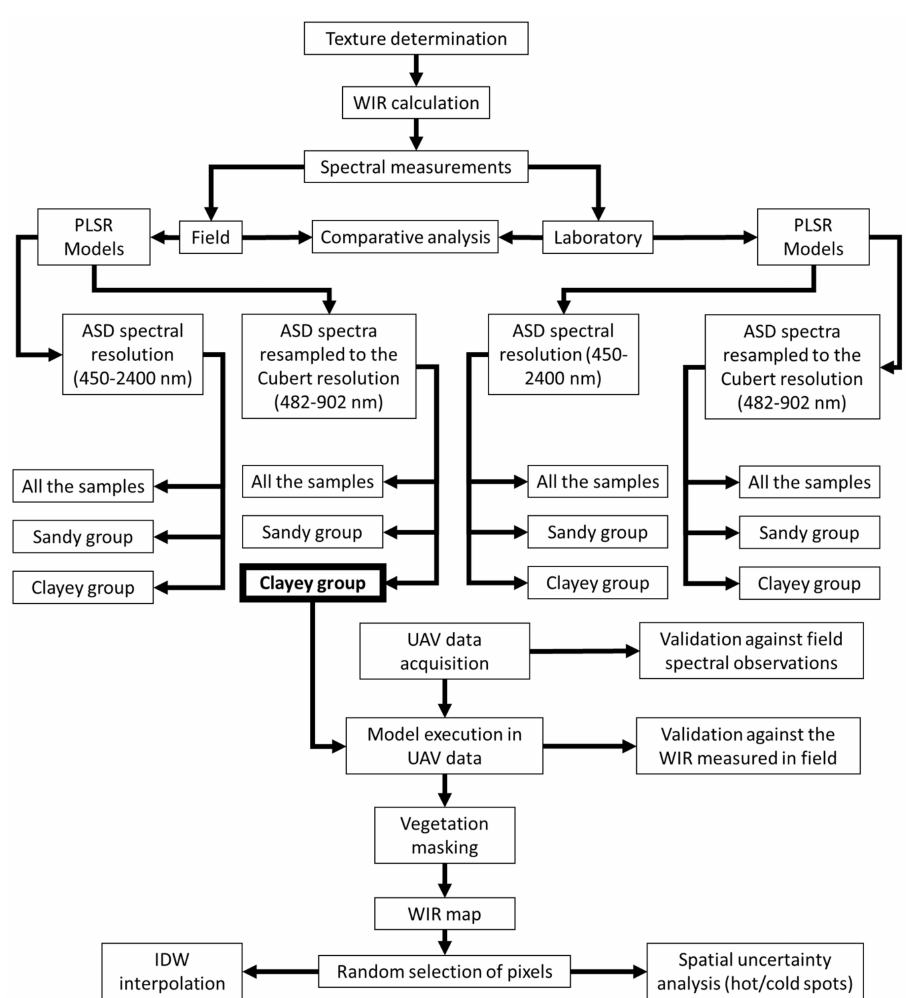
Figure 4. Flowchart of the methods followed in this